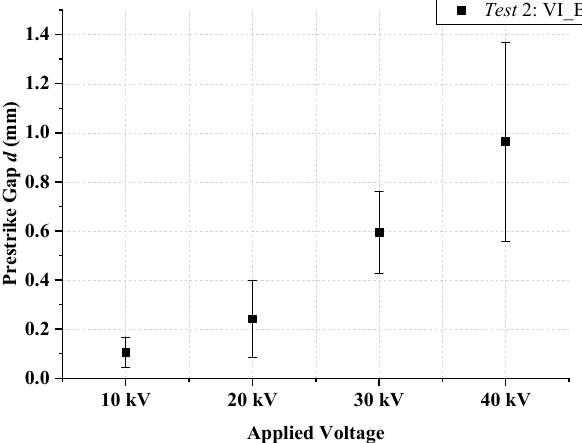
Figure 7. The relationships between d 50 and applied voltage U s in Test 1 with VI_A.